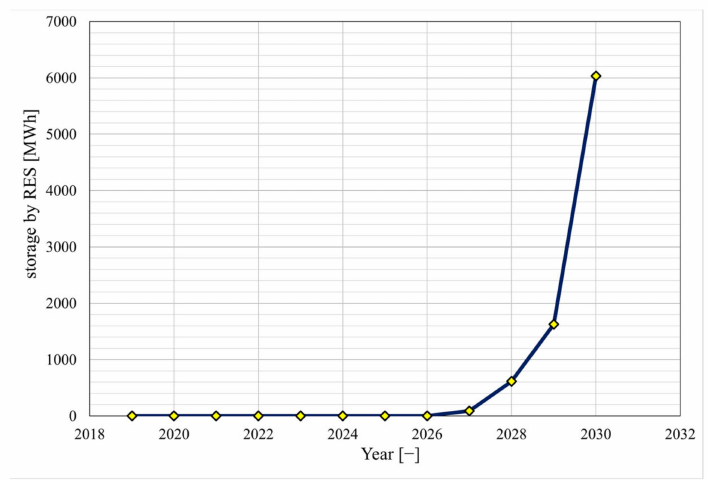
Figure 6. Total annual electrical energy storage requirements generated by